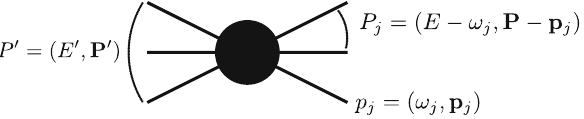
Fig. 2 Momenta labels for three particles. The left side denotes the final state particles, while the right is the initial state